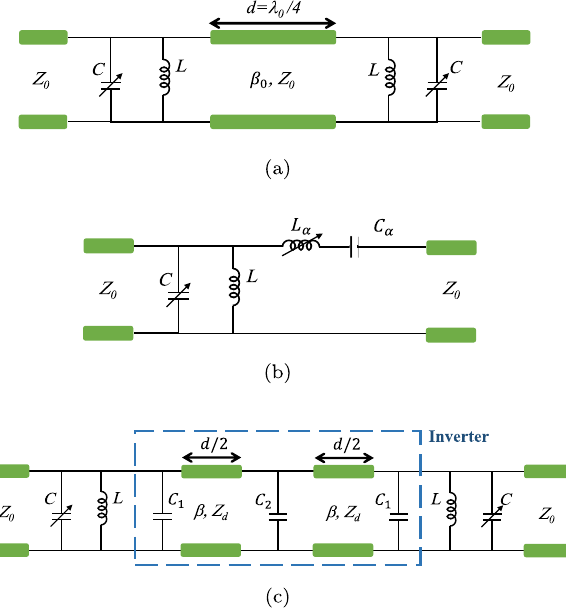
FIG. 5. (a) A tunable, transmission-line phase shifter that maintains an impedance match (low insertion loss) over its tunable range. (b) Equivalent circuit of the phase shifter shown in Fig. 5(a). (c) A tunable phase shifter employing an impedance inverter instead of a quarter-wavelength transmission